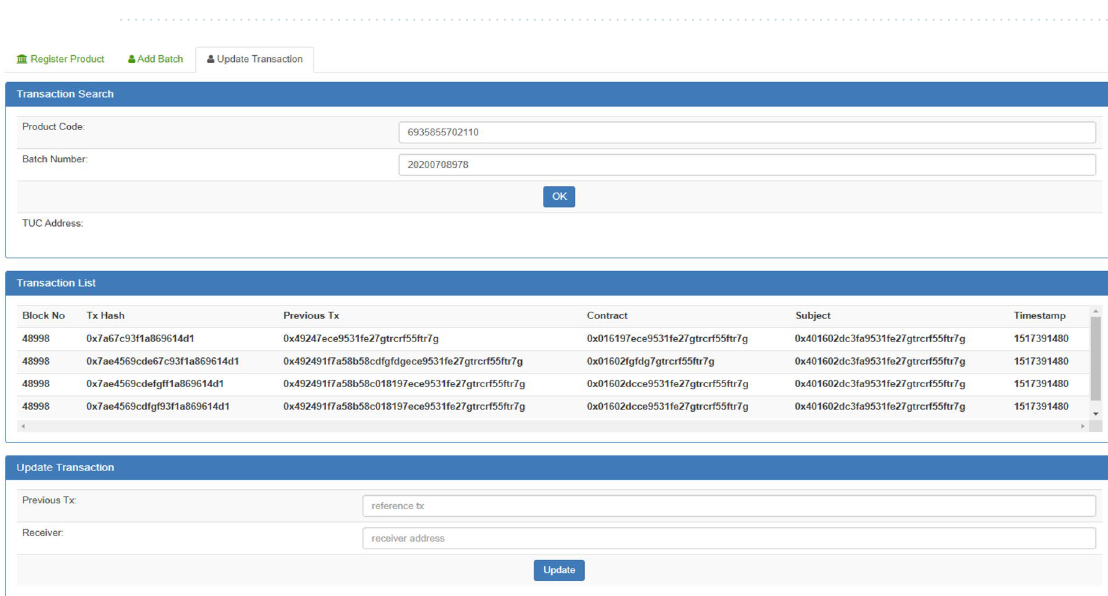
Figure 17. The registration process of the products on blockchain based App.